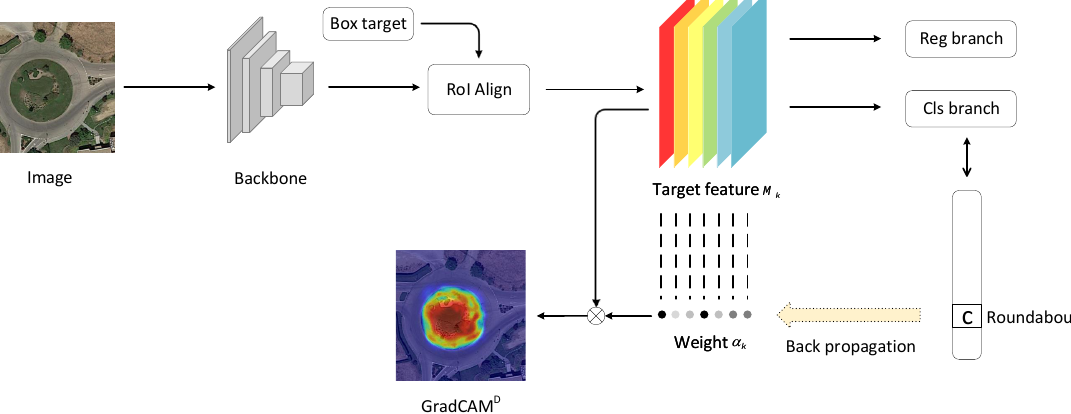
Figure 4. Overview of the GradCAM D . We generate GradCAM D using back propagation in the detector’s classification branch. Best viewed in color.